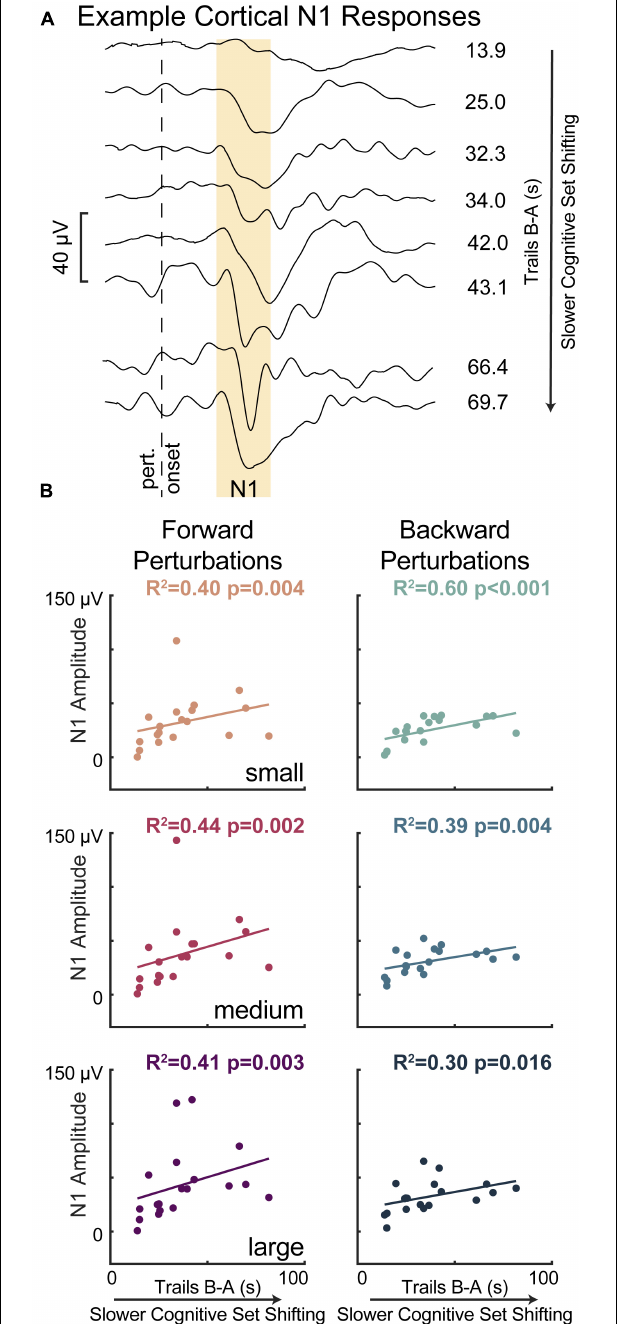
FIGURE 5 | Slower cognitive set shifting was associated with larger perturbation-evoked cortical N1 responses. (A) Cortical responses are shown at the Cz electrode for eight different participants (averages across all trials) as examples along with their set shifting scores. The gold box highlights the window of 100–200 ms, in which the N1 amplitude was quantified. (B) Cortical N1 response amplitudes are plotted against cognitive set shifting scores in each of the perturbation conditions. Forward movements of the floor (resulting in backward leaning posture) are represented in magentas and backward movements of the floor are represented in blues, with darker colors for larger